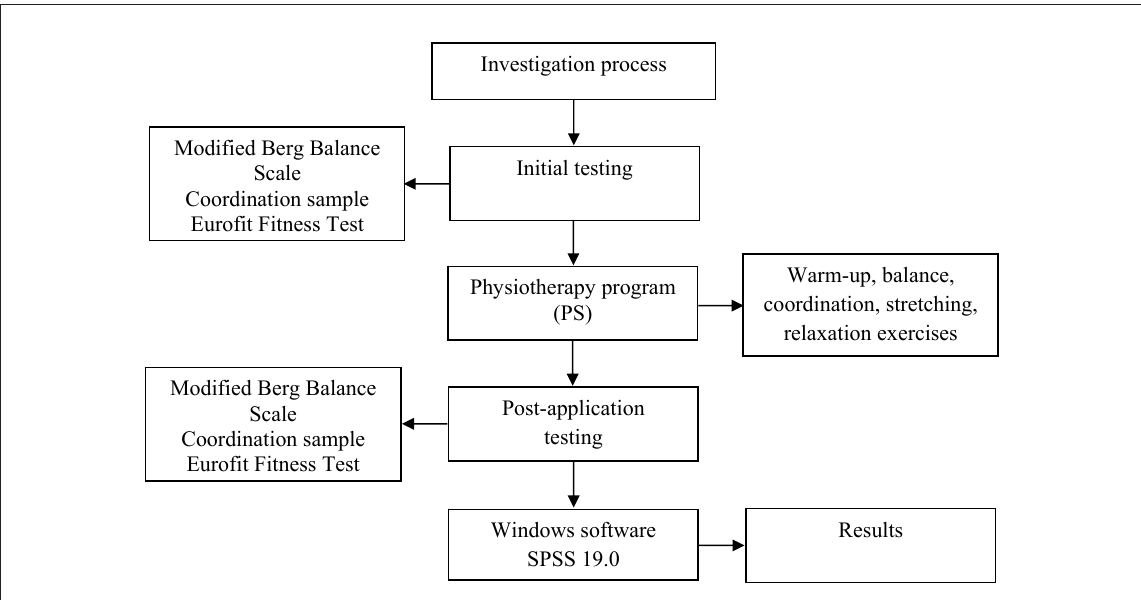
Figure. The scheme of the investigation process applied individually for each participant